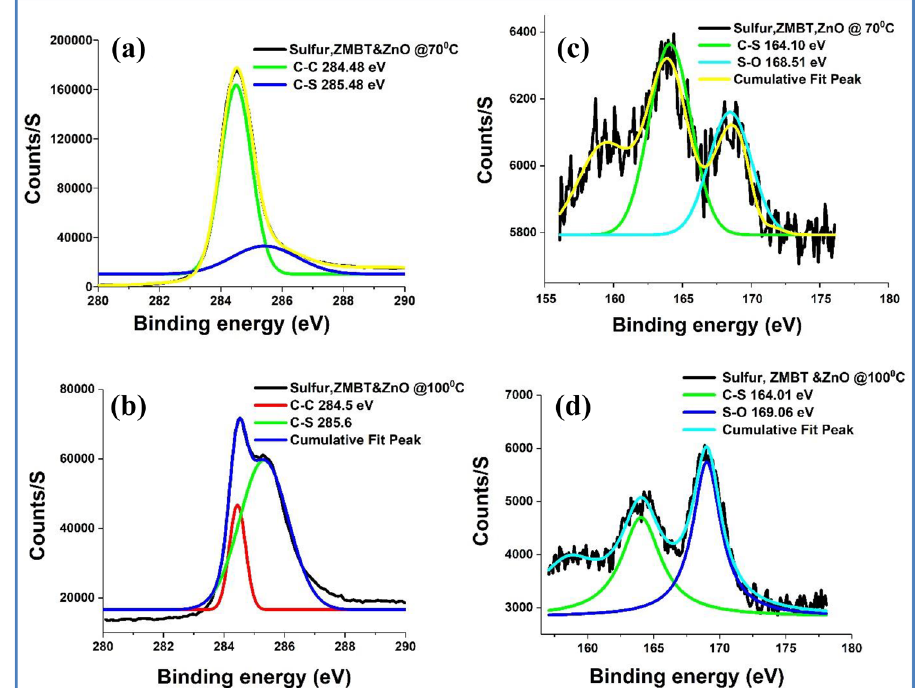
Figure 5. XPS spectra for C1s for sulfurated FLG prepared ( a ) at 70 °C and ( b ) 100 °C. S2p spectra for sulfurated FLG prepared ( c ) at 70 °C and ( d ) 100